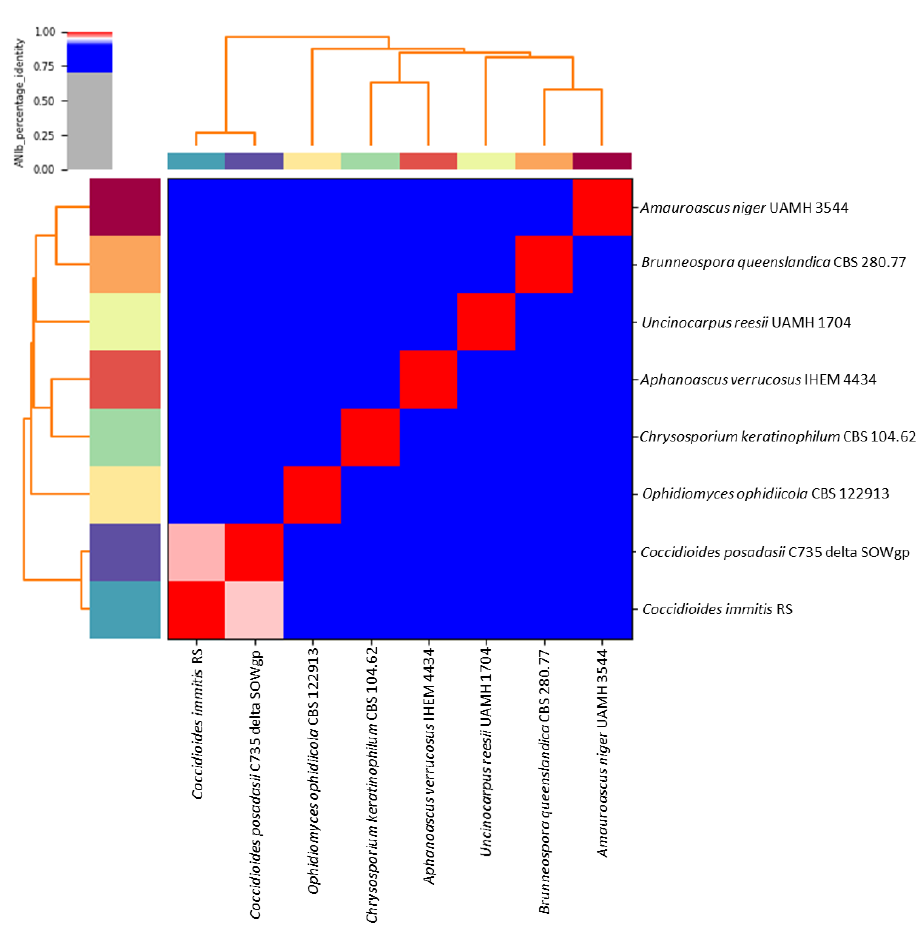
Figure 2. Heatmap generated showing average nucleotide identities (ANIs) with Pyani. Genome comparison of the draft genome of Chrysosporium keratinophilum CBS 104.62 and other Onygenales species. The heatmap shows the level of similarity, whereby the red color (100%, 1.0 ident.) gives high similarity and gray color (70%, 0.7 ident.) shows low similarity.